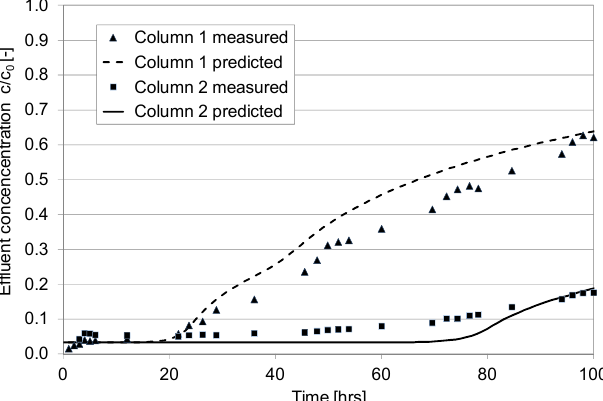
Figure 6. Experimental and predicted breakthrough curves of pre-treated HTC spent grains PW.